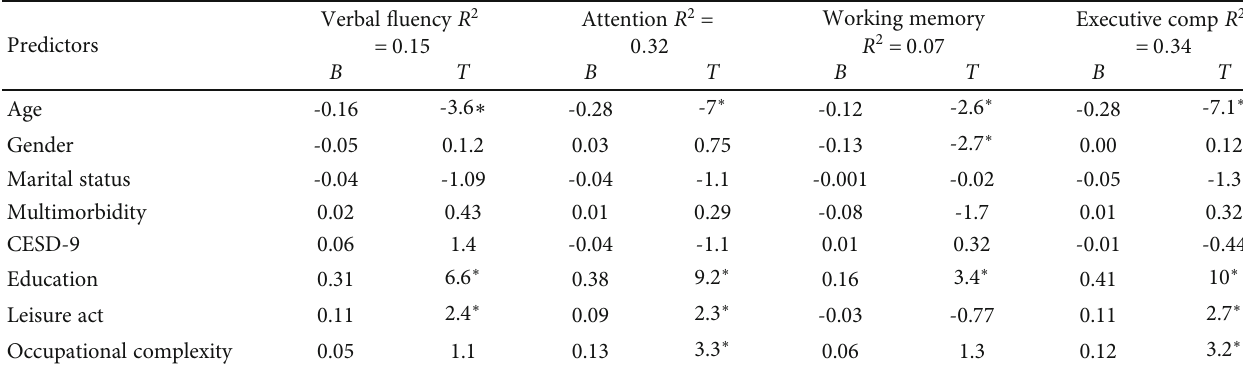
Table 4: Multiple regressions predicting executive function